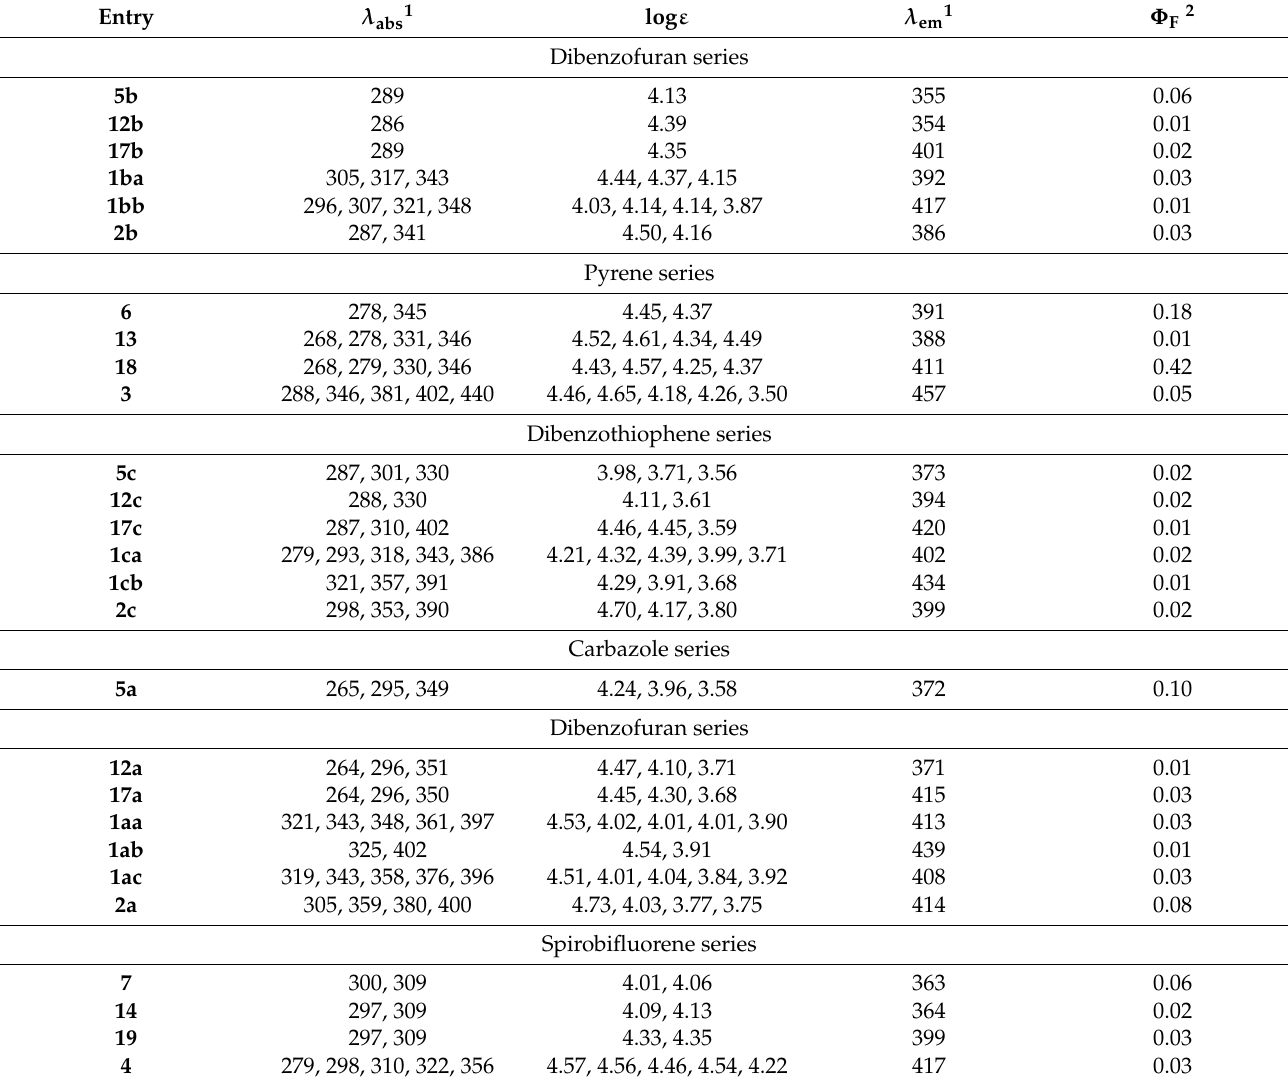
Table 1. Photophysical data of CH 2 Cl 2 for thiahelicenes and relative